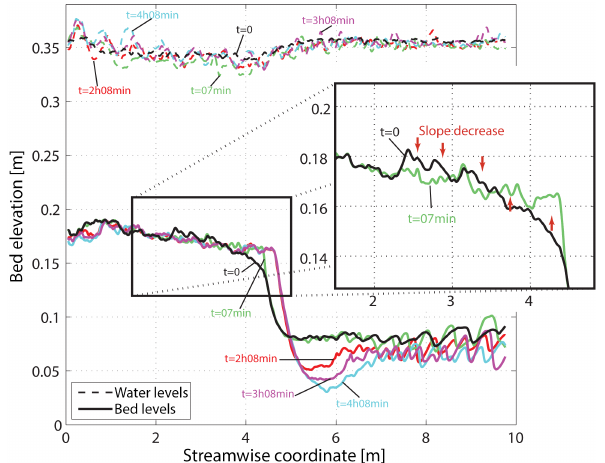
Figure 6. Measured water surface and bed elevation profiles of Experiment T 2 at t = 0h07min, 2h08min, 3h08min, and 4h08min. The enlarged window shows the degradation occurring during the armor breakup. Flow is from left to right. The profiles were smoothed using a Gaussian filter.